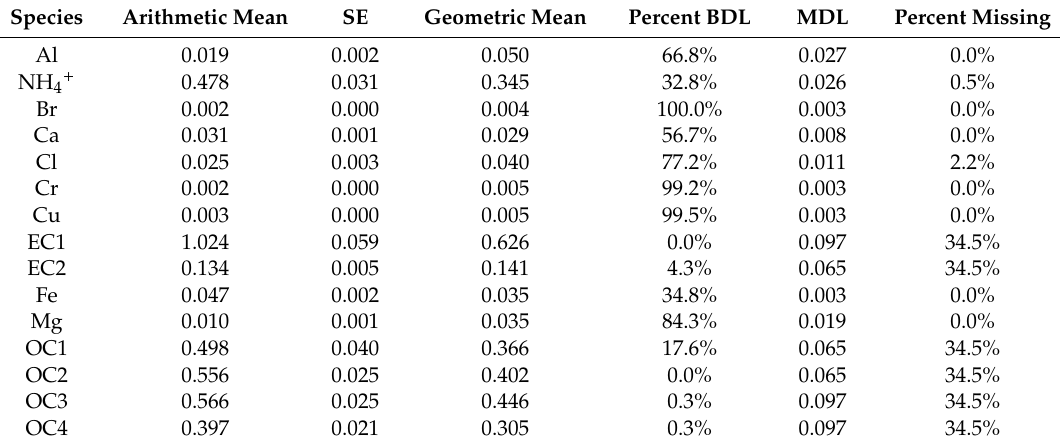
Table 3. Statistical summary of PM 2.5 species concentration ( µ g / m 3 ) in Fairbanks from November 2013 to May 2019 (BDL: below detection limit; MDL: method detection limit). Samples were collected every three days. The August–December 2014 period with no species measurements has been excluded. The geometric mean was calculated using data above the